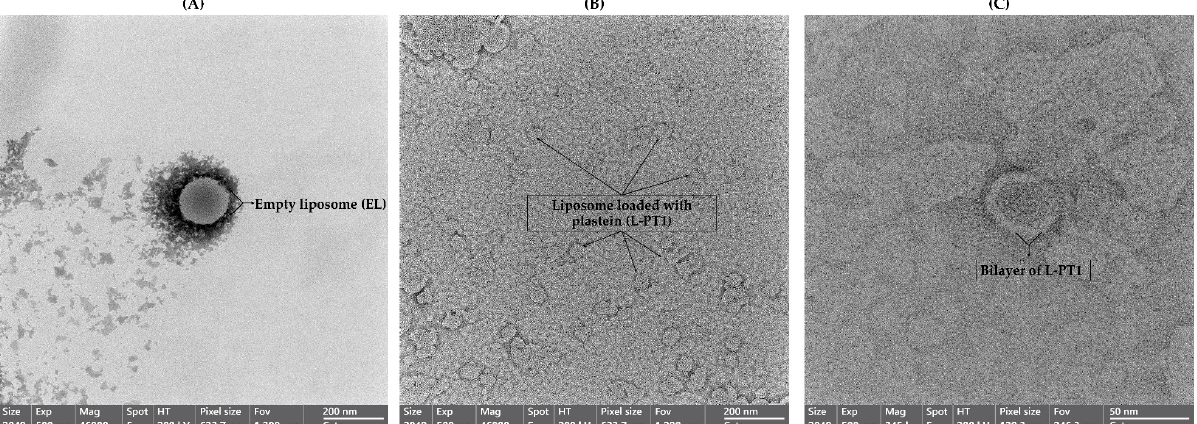
Figure 3. Transmission electron microscopic (TEM) image of ( A ) empty liposome (EL) at 46,000× magnification, ( B ) liposome loaded with 1% plastein (L-PT1) at 46,000× magnification and ( C ) L-PT1 at 245,000× magnification.